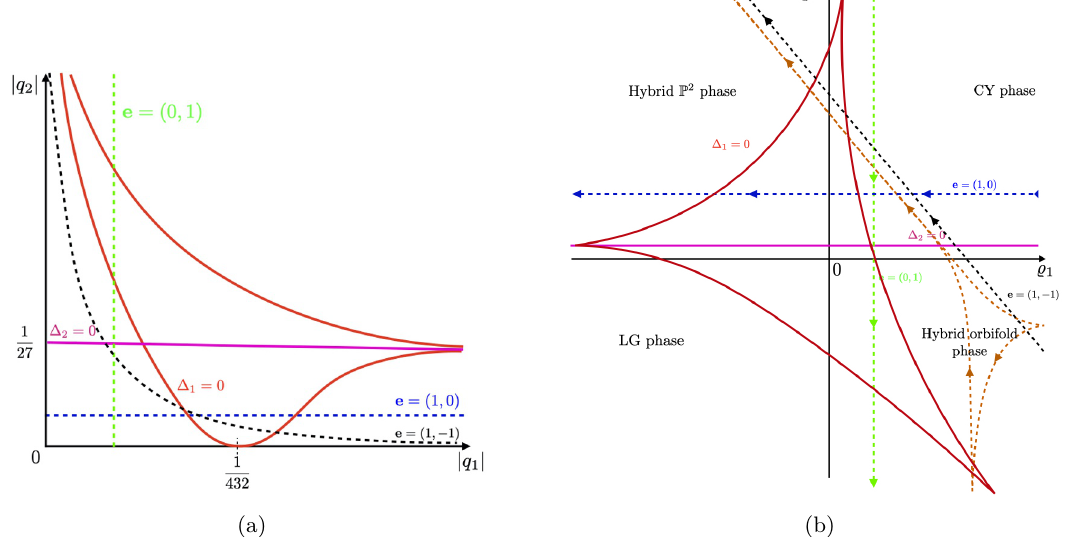
Figure 3. Two sketches of the FI-parameter space. On the left we show the singular divisors { ∆ 1 = 0 } (red) and { ∆ 2 = 0 } (magenta) for q 1 , q 2 ∈ R in the ( | q 1 | , | q 2 | ) -plane. The right shows the same in terms of % i = − 1 log | q i | . On the right we also indicated the four different weak-coupling phases 2 π of the GLSM. The dashed lines correspond to the projection of the solution profiles for EFT strings with charges e = (1 , 0) (blue) and e = (0 , 1) (green). We have also included a non-EFT string with charge e = (1 , − 1) , plotting both the naive profile (black) and the actual profile (orange) that repro- duces the large-volume NS5-brane monodromy. The arrows indicate the embedding of the space- time P 1 into the two-cycle in the FI-parameter space. Following the arrows one moves from the string core at z = 0 to z = ∞ . From the figure it is easy to see that the set of two-cycles associated to an el- ementary string sweeps the whole FI-parameter space. The same occurs for the actual moduli space M , where they form a complex-dimension-one foliation over the corresponding divisor at